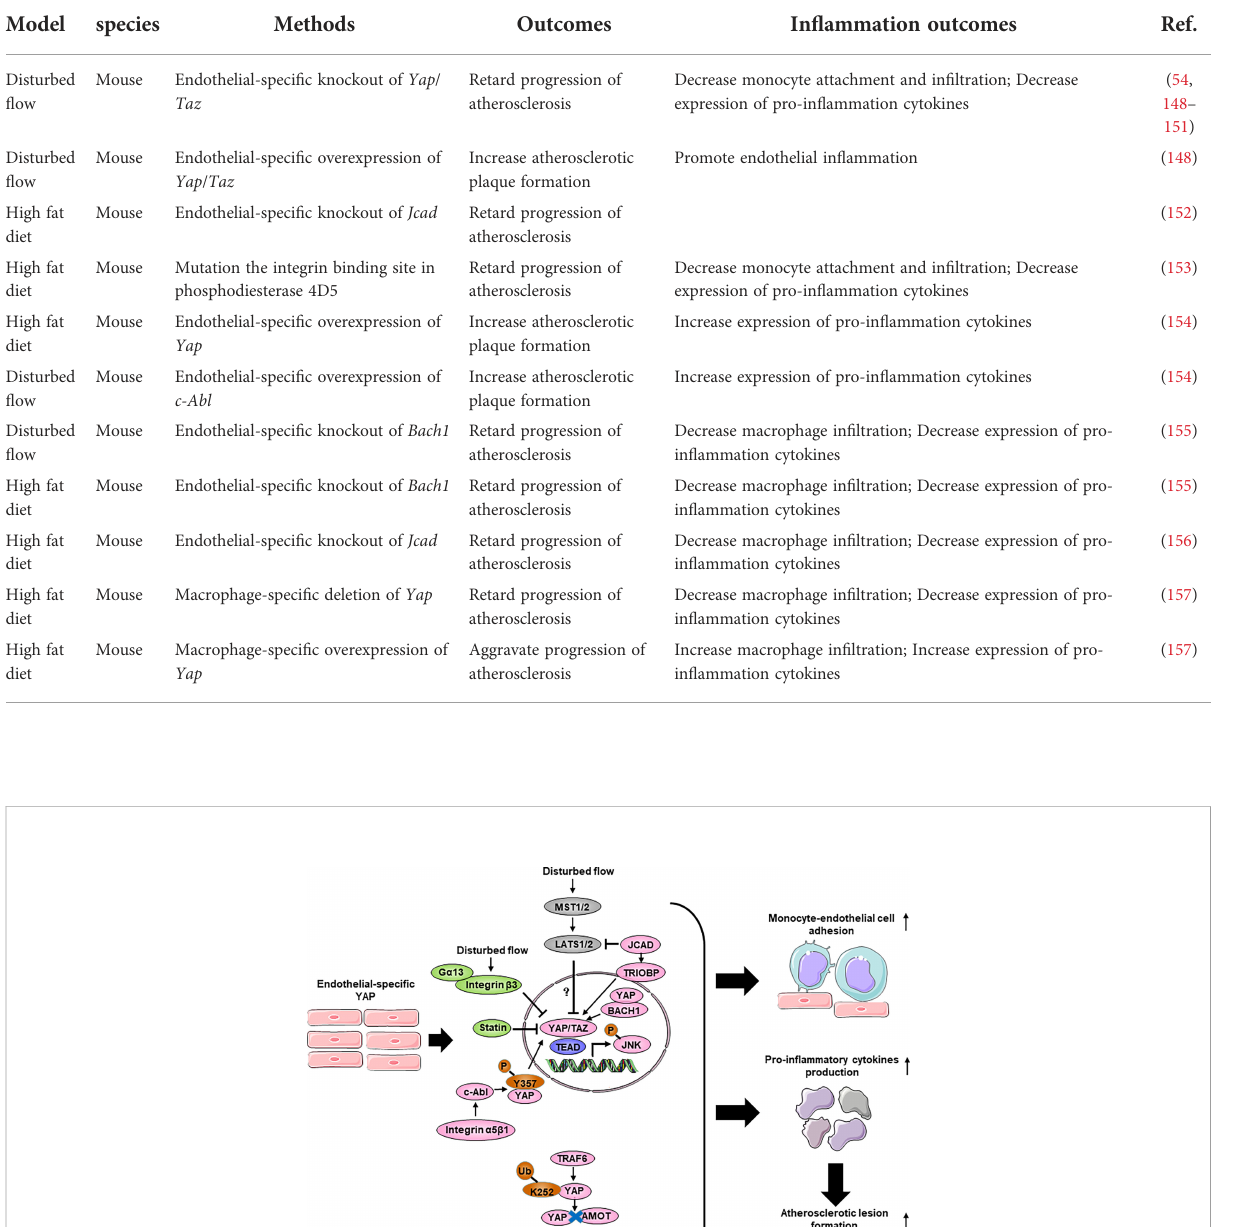
TABLE 3 Hippo-YAP pathway and in fl ammation in atherosclerosis.